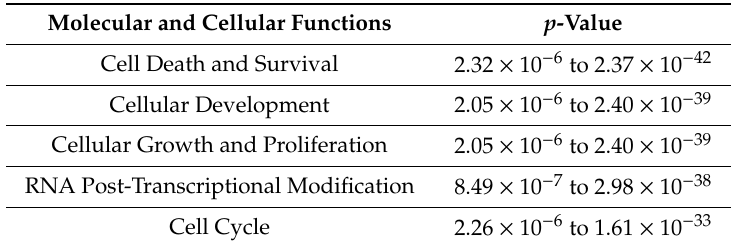
Table 3. Top molecular and cellular functions of the di ff erentially expressed genes in H1975 cells treated with HGK at 50 µ